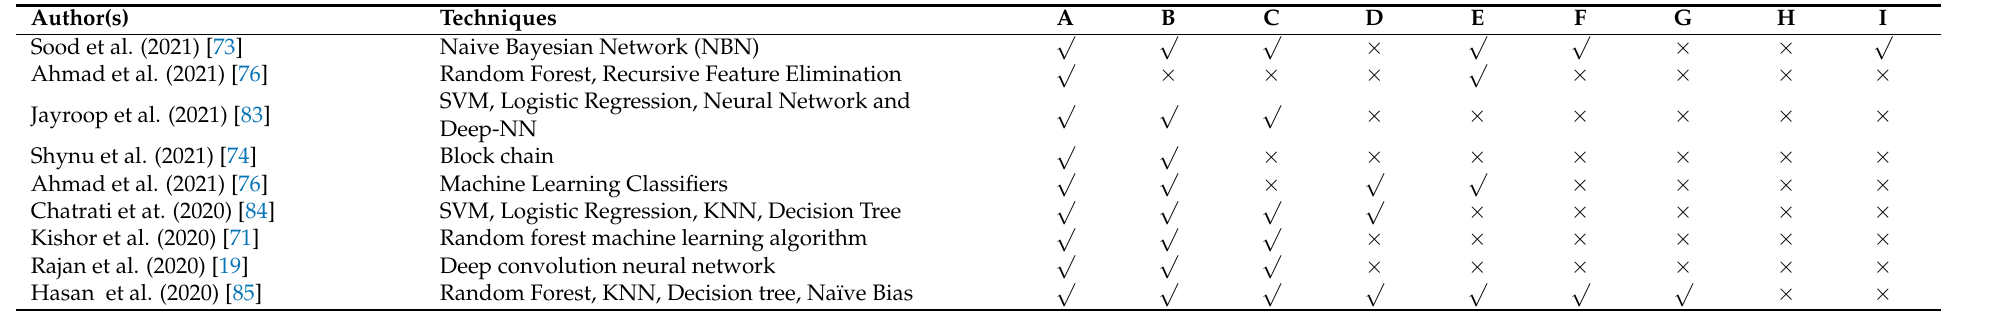
Table 2. Comparative analysis of various parameters of healthcare